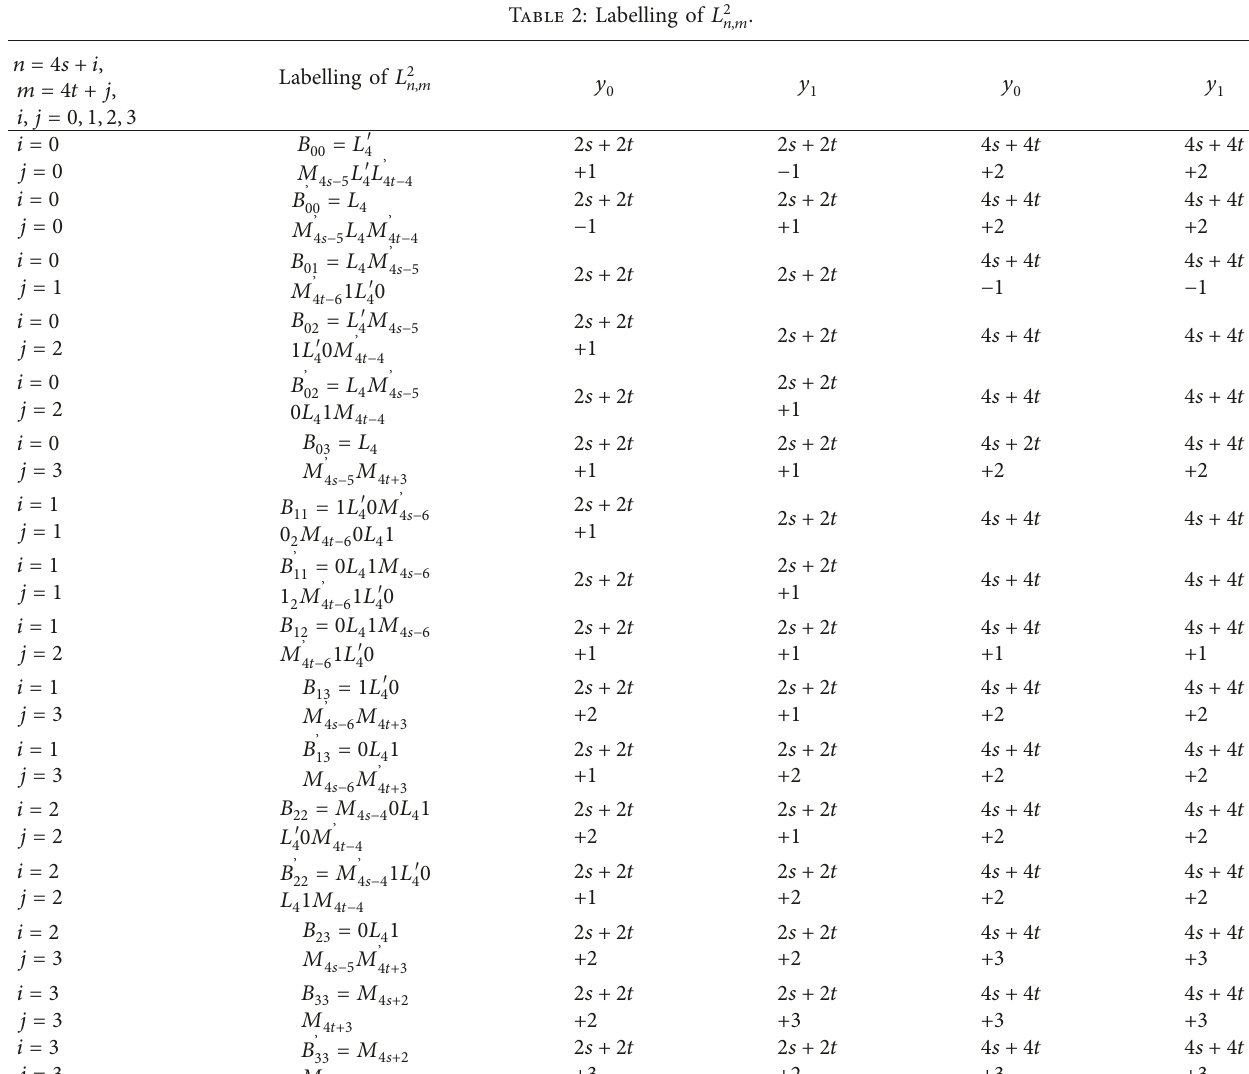
Table 2: Labelling of L 2